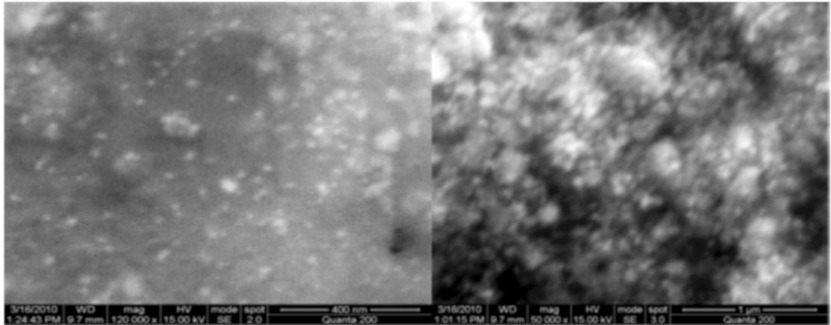
Figure 9. SEM image of Ag-NP having irregular shape and obtained in [176]. At a scale of 400 nm ( left ) and at a scale 1 m ( right